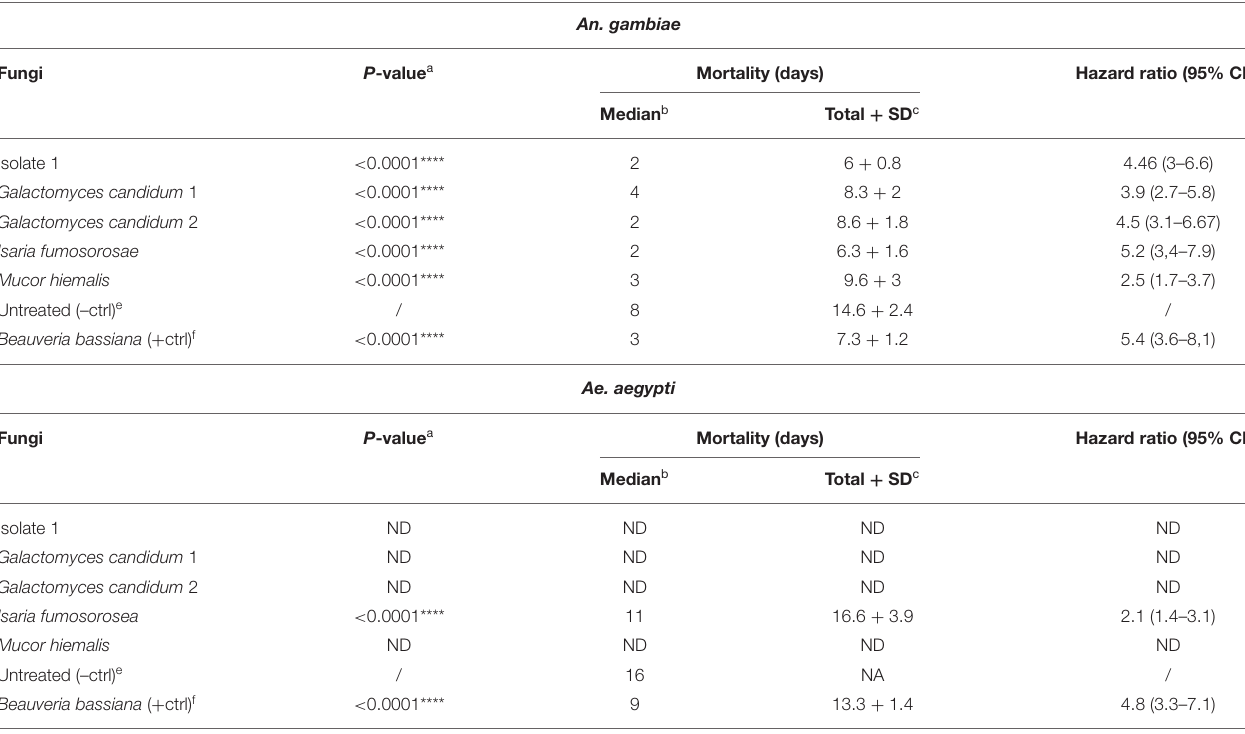
TABLE 3 | Mortality of An. gambiae and Ae. aegypti mosquitoes exposed to spore solution in the dipping assay.